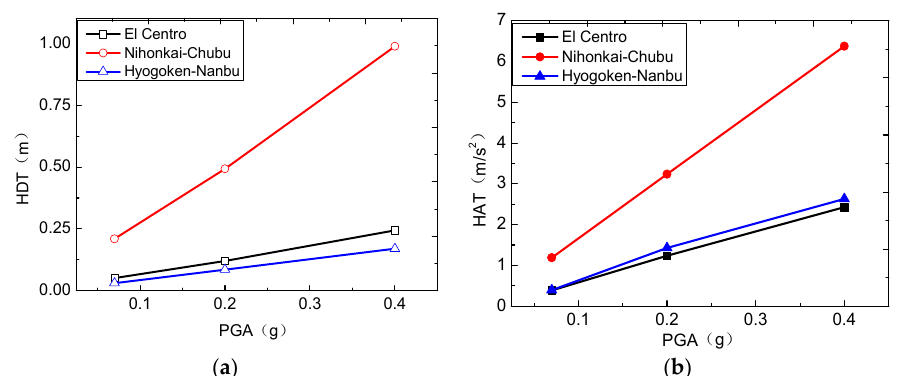
Figure 10. Hyogoken-Nanbu earthquake.